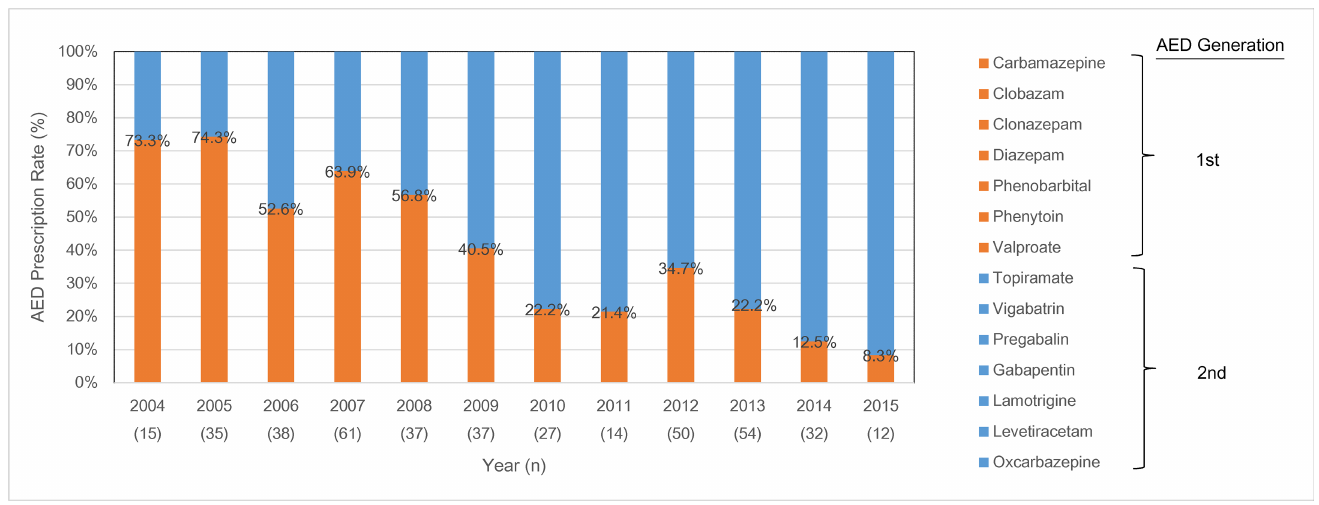
Fig 2. AED prescription by year (2004–2015) and AED generation (1st vs. 2nd) (Total AEDs prescribed: n = 411).